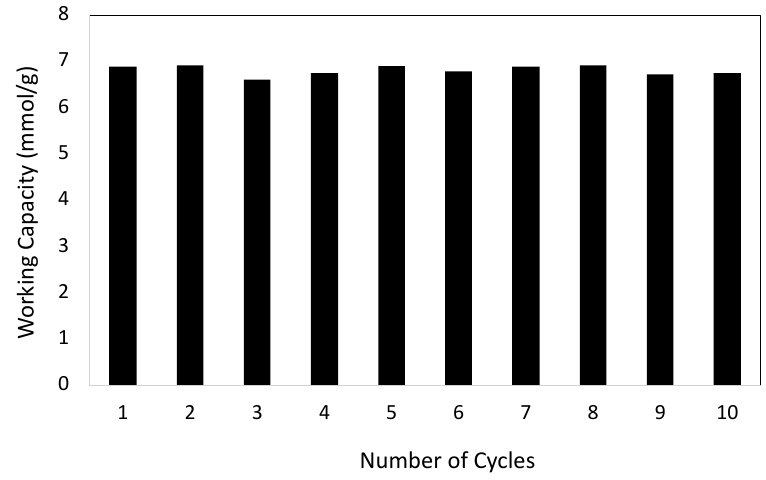
Figure 7. Cyclability of working capacity of CO 2 adsorption in LS-5.